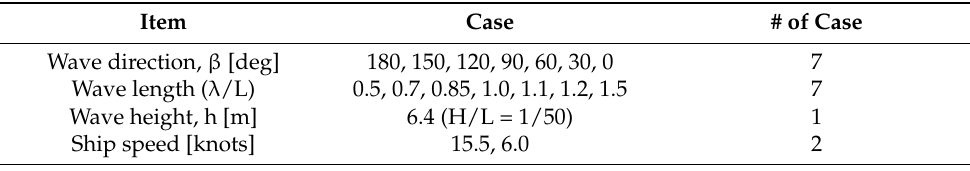
Table 2. Test cases of model test.